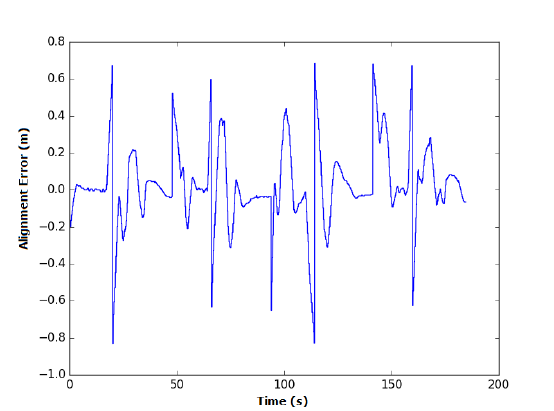
Figure 22. Variation in the alignment error during experiment 3 in Shared